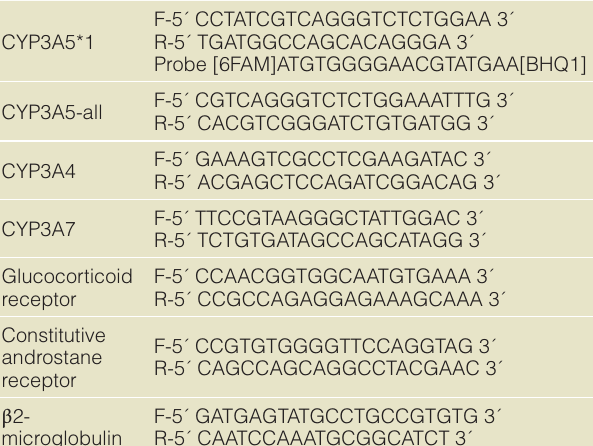
Table 1. Primer sequences for qPCR